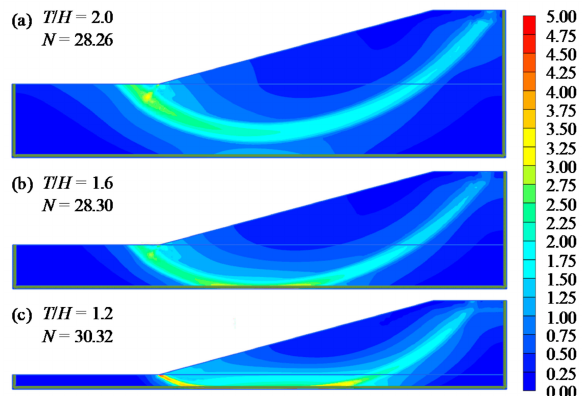
Figure 6. Total deviatoric strain according to T / H , where H / B = 0.5, c u 1 / c u 2 = 1, β = 15 ◦ ( a ) T / H = 2.0, ( b ) T / H = 1.6, and ( c ) T / H = 1.2.